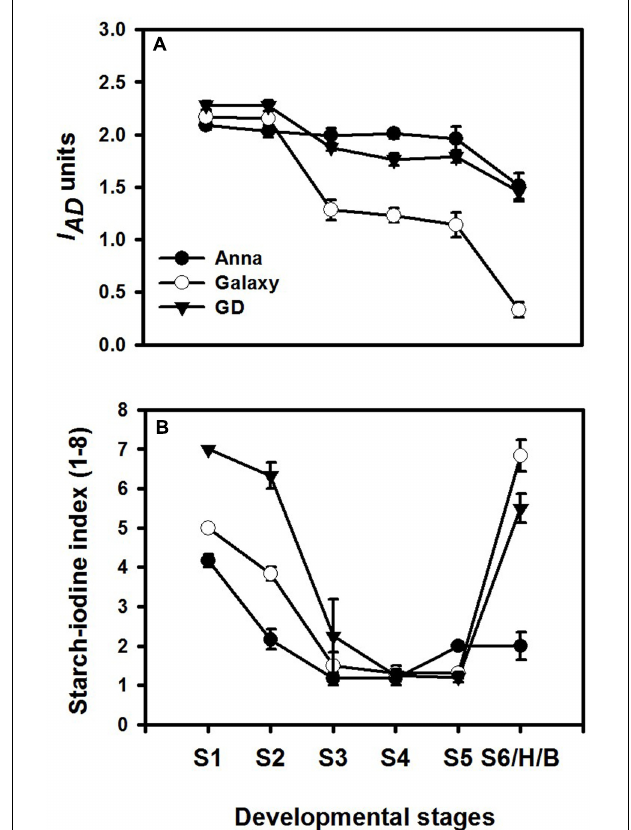
FIGURE 5 | Chlorophyll and starch content at different stages of fruit development. (A) Chlorophyll content was measured by DA meter on two opposite sides of each fruit, and expressed as index of absorbance difference ( I AD ). Each value represents the mean of 10 fruit and vertical bars indicate ± SD. (B) Starch content was expressed as starch–iodine index, ranked on the scale of 1–8, where index-1 indicated highest starch content; however, index-8 corresponds to lowest starch content. Each value represents the mean of 10 fruit and vertical bars indicate ±